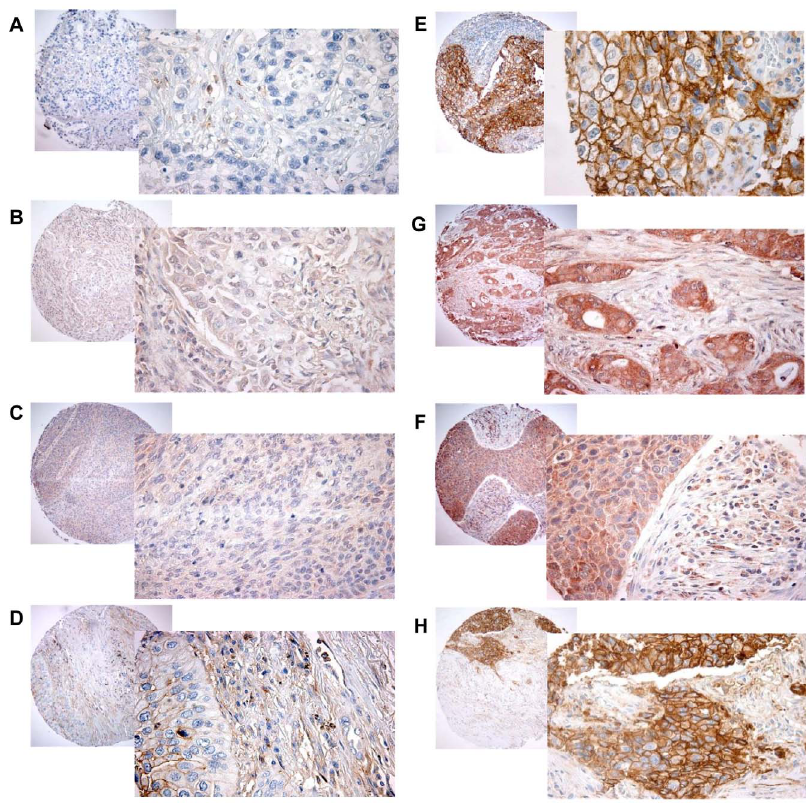
Figure 2. Immunhistochemical staining of MCT1–4 in NSCLC. Low expression: A) MCT1, B) MCT2, C) MCT3, D) MCT4. High expression: E) MCT1, F) MCT2, G) MCT3, H) MCT4. 100 6 and 400 6 magnification.